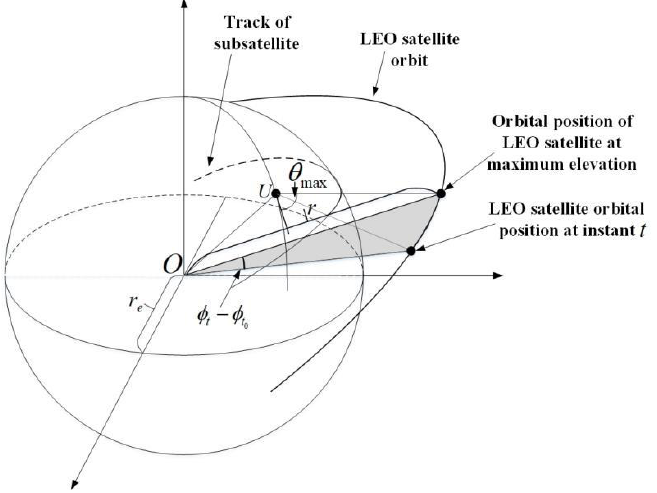
Figure 3. Geometric diagram of LEO satellite’s orbital motion relative to the user terminal.